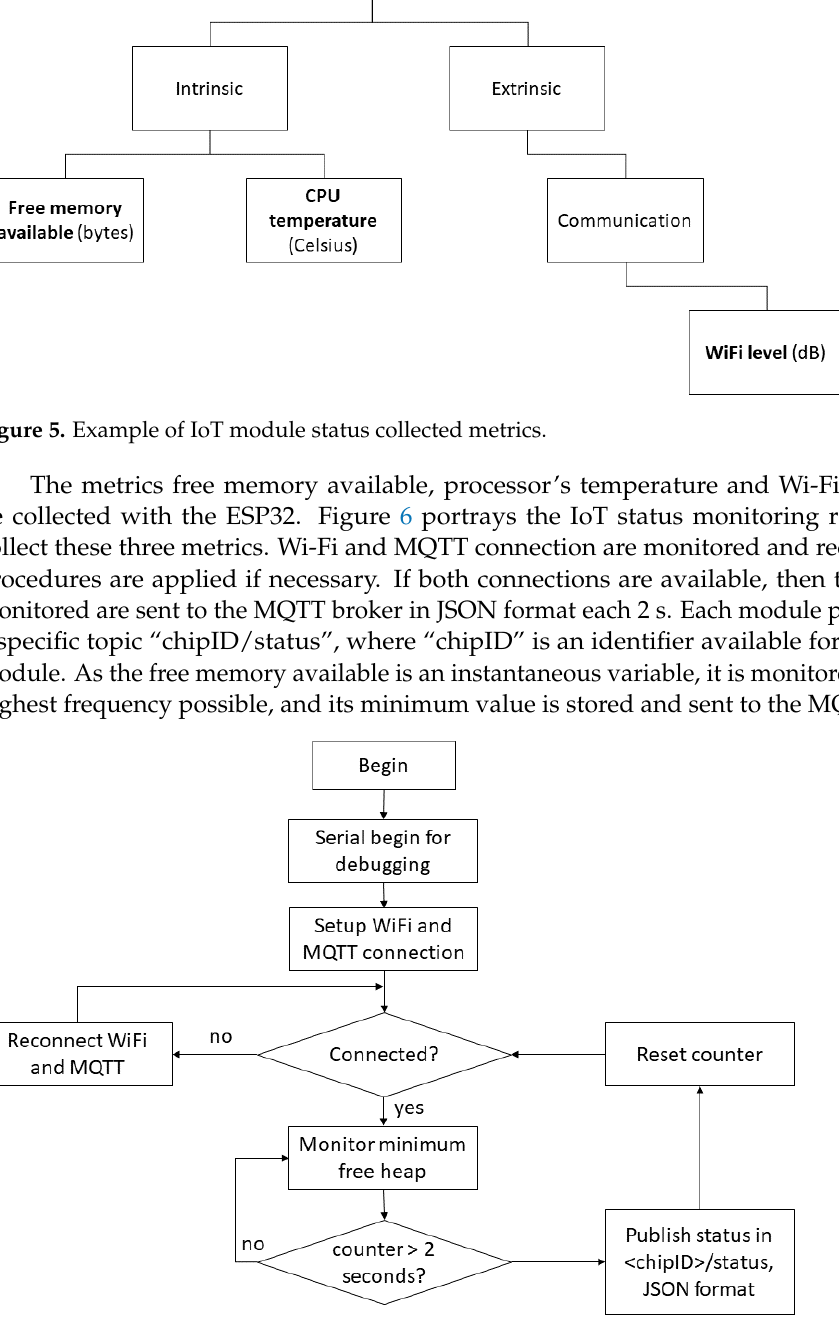
Figure 6. IoT module flowchart for status publishing in a MQTT